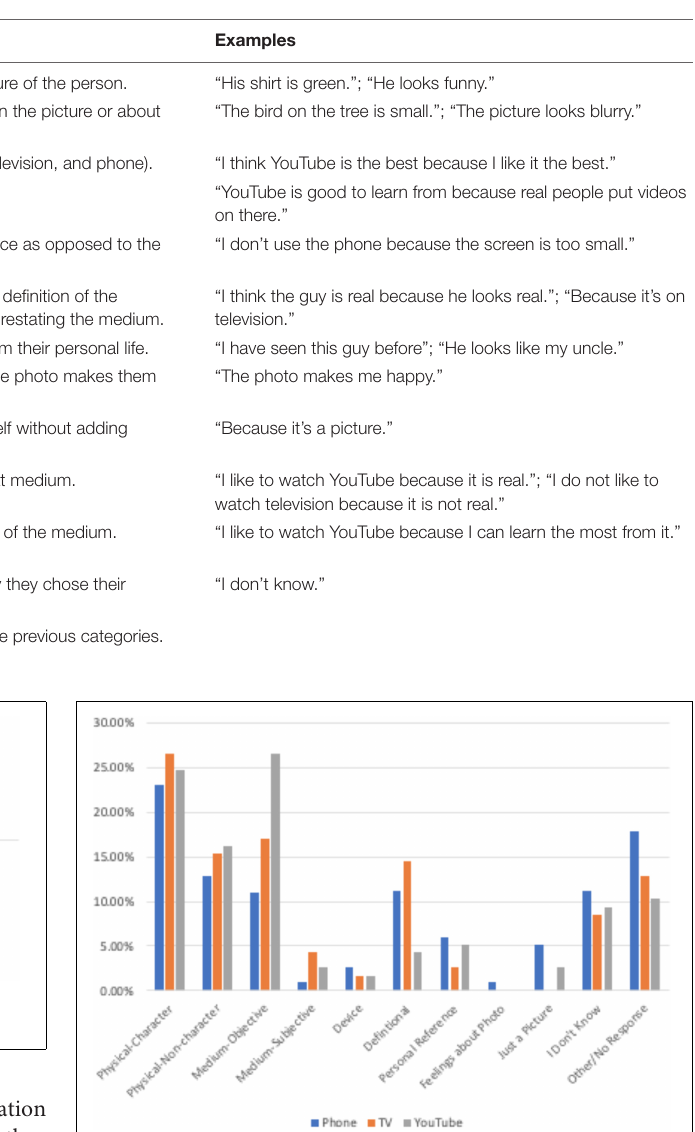
TABLE 2 | Coding scheme for open-ended responses.